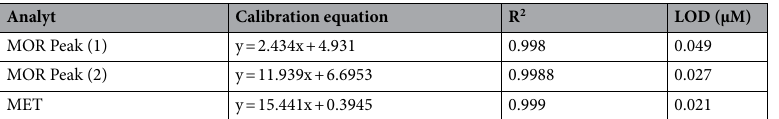
Table 1. Regression equations, calibration coefficient, and detection limit of GC/CMK-5 electrode for individual detection of MOR and MET.